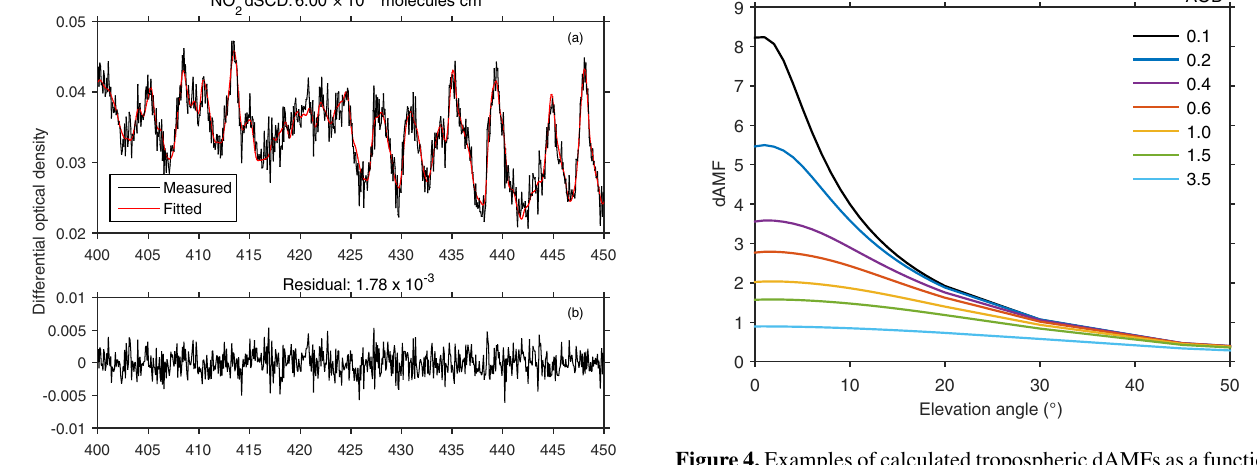
Figure 4. Examples of calculated tropospheric dAMFs as a function of elevation viewing angle for different values of the aerosol optical depth (AOD) at